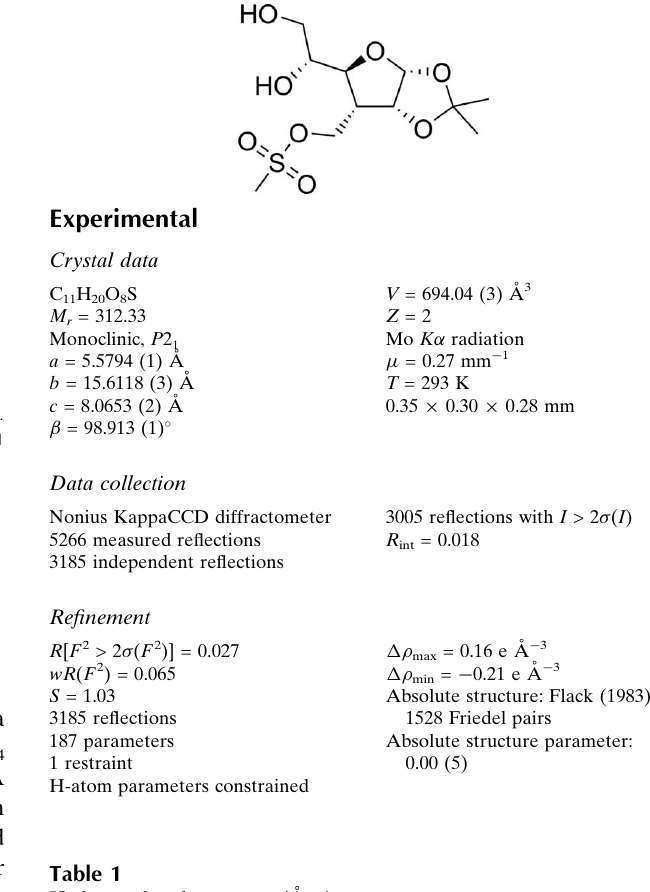
Hydrogen-bond geometry (A˚ , (cid:2)